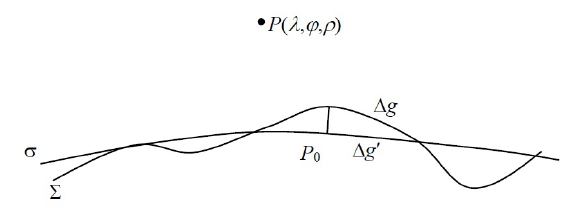
Fig. 1. Boundary surface of Molodensky Problem